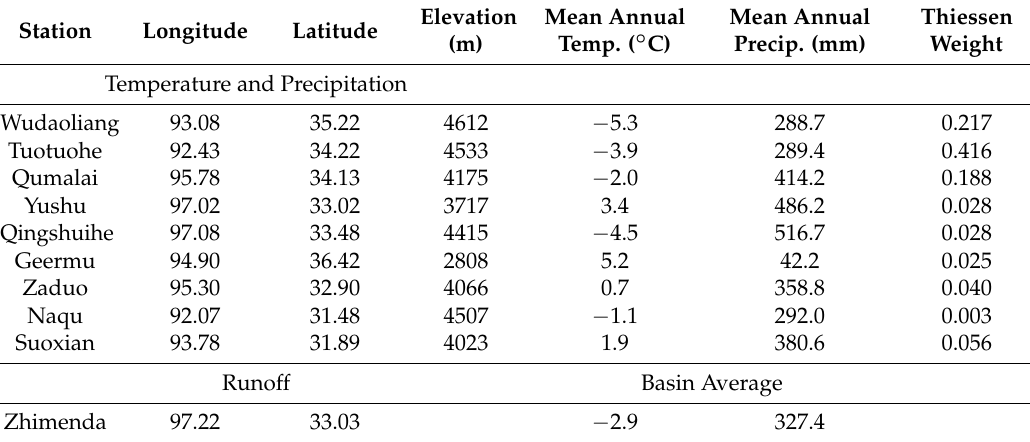
Table 1. Hydro-climatic stations used in the